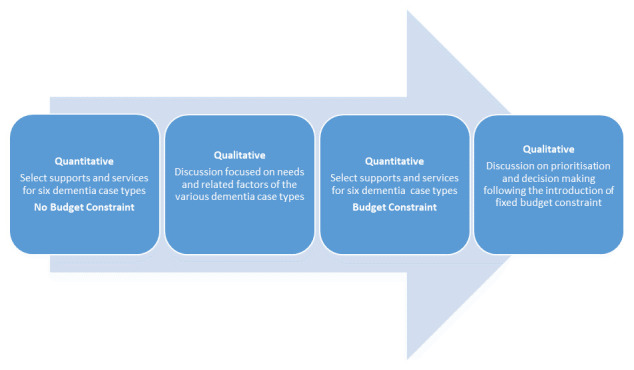
Research design.